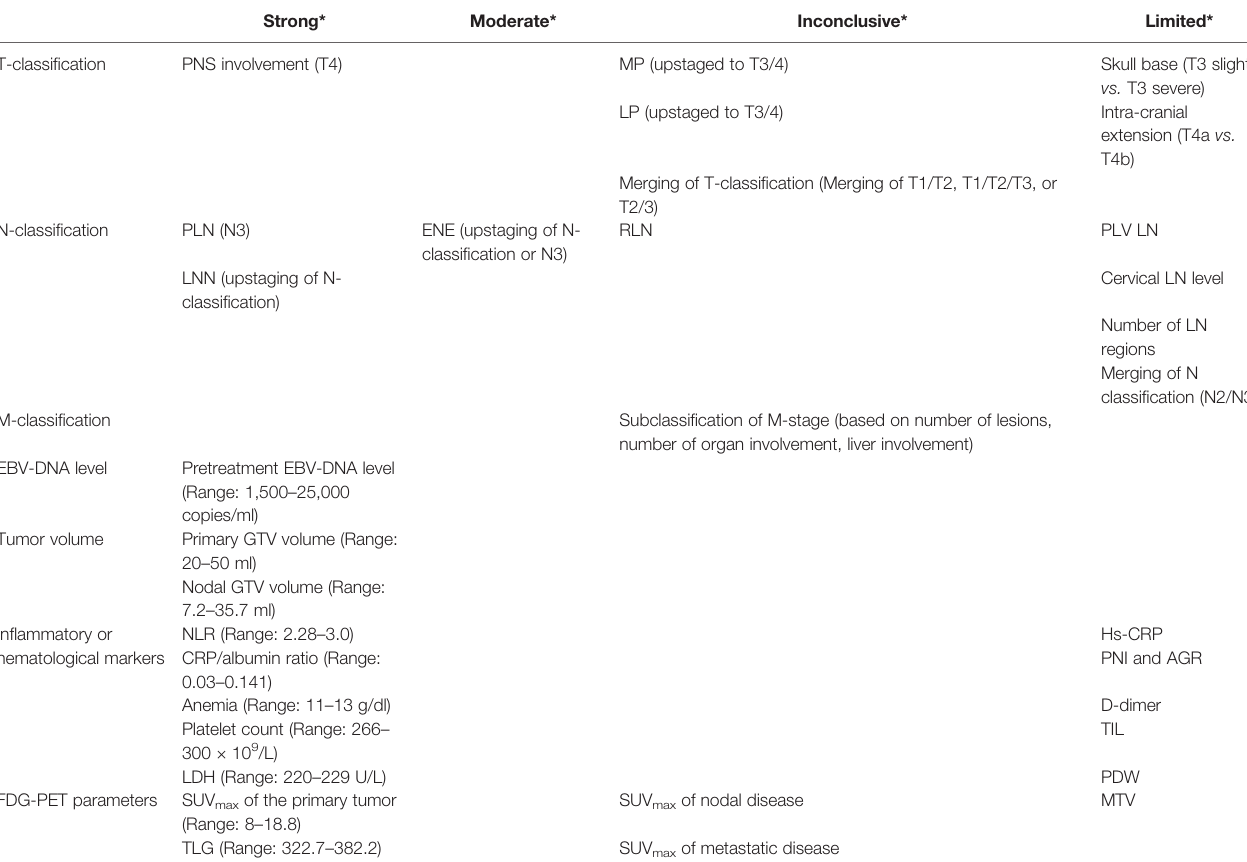
TABLE 1 | Proposed prognostic factors and the level of evidence for